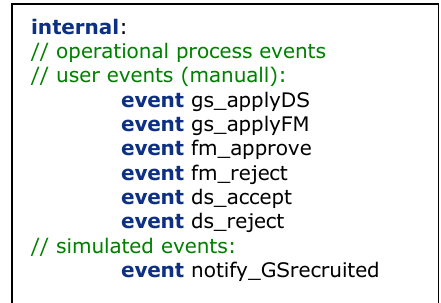
Figure 4. Events defined for the Operational PhD recruitment